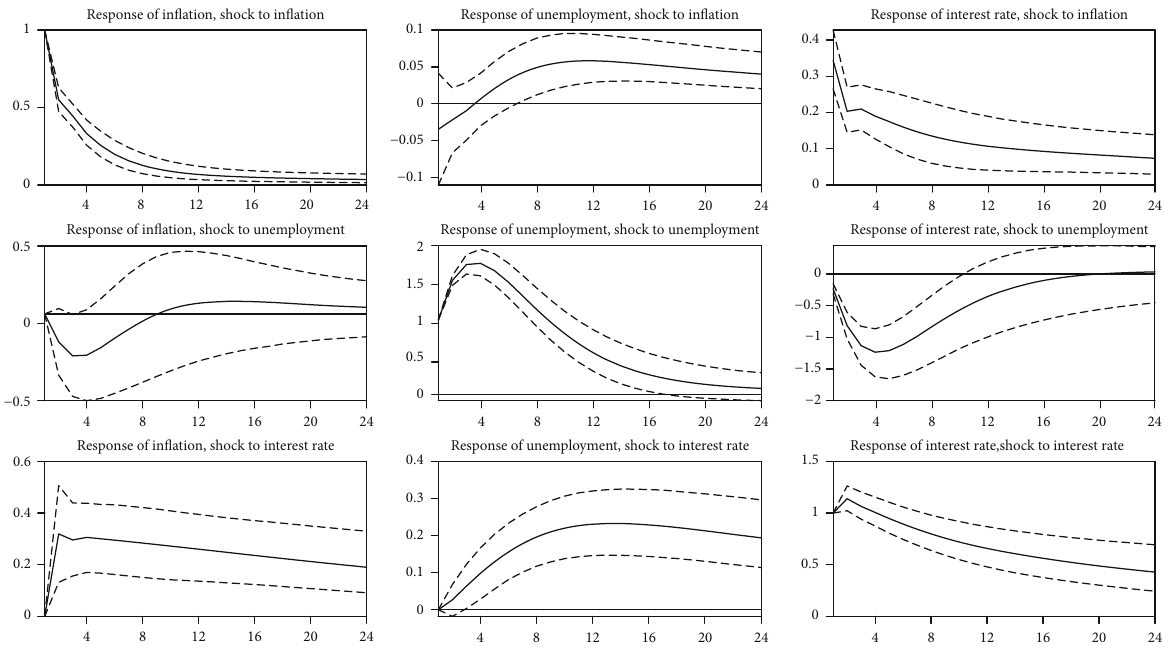
Figure 3: Impulse response